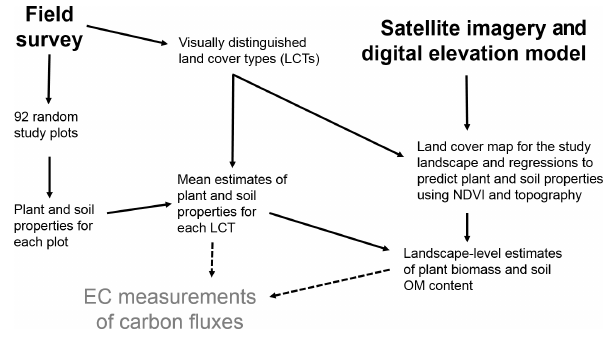
Figure 2. A diagram of the working steps of the study. The study was carried out to support ongoing eddy covariance (EC) measure- ments of carbon fluxes in the study